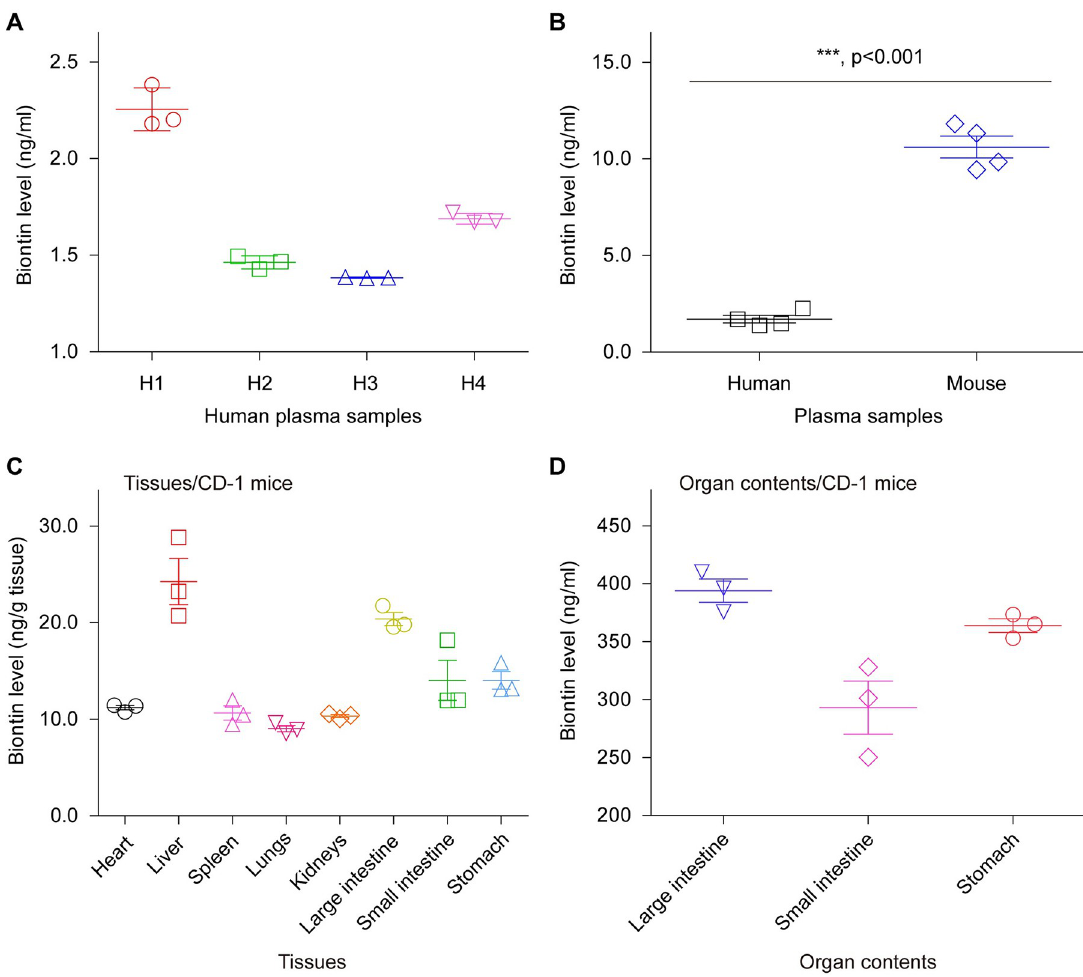
Fig 6. Comparison of biotin level in human plasmas and various mouse tissues (and/or organs). A. Relatively-low level of biotin is measured in human plasma samples. Blood plasmas of four human individuals (H1 to H4) were subjected for the routine biotin measurement. Biotin level of human plasma varies from 1.38 to 2.38 ng/ml (i.e., 5.65 nM to 9.74 nM), which is generally consistent with the observation with human biotin by Carfrae and coworkers [15]. B. Contrasting plasma biotin level in CD-1 mice and humans. The average biotin level (10.61 ng/ml; 43.43 nM) in mouse plasma is around 6-fold higher than the counterpart (1.70 ng/ml; 6.96 nM) in the human individual. C. The determined level of biotin assigned to an array of tissues of CD-1 mice Totally, eight tissues examined here include heart, liver, spleen, lungs, kidneys, large intestine, small intestine, and stomach. D. Measurement for biotin level in organ contents from CD-1 mice. Biotin level was measured using CD-1 mice (5–6 weeks). The organ contents were separately collected from large intestine, small intestine, and stomach. All the data are expressed in means ± SD, and assayed by two-tailed analysis of variance. Clearly, biotin level (300–400 ng/ml) in organ contents is over 20-fold higher than the equivalents (10–20 ng/ml) in associated